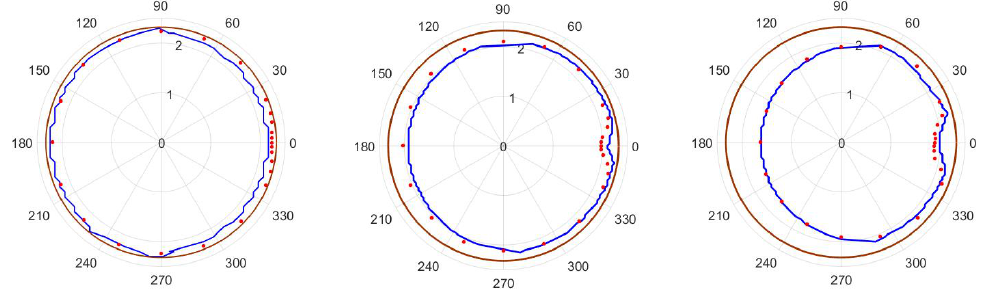
Figure 10. Maximum inundation area of numerical result (blue lines) and experiment (red stars). The solid brown lines represent the initial shoreline. From left to right, case A, case B and case C.